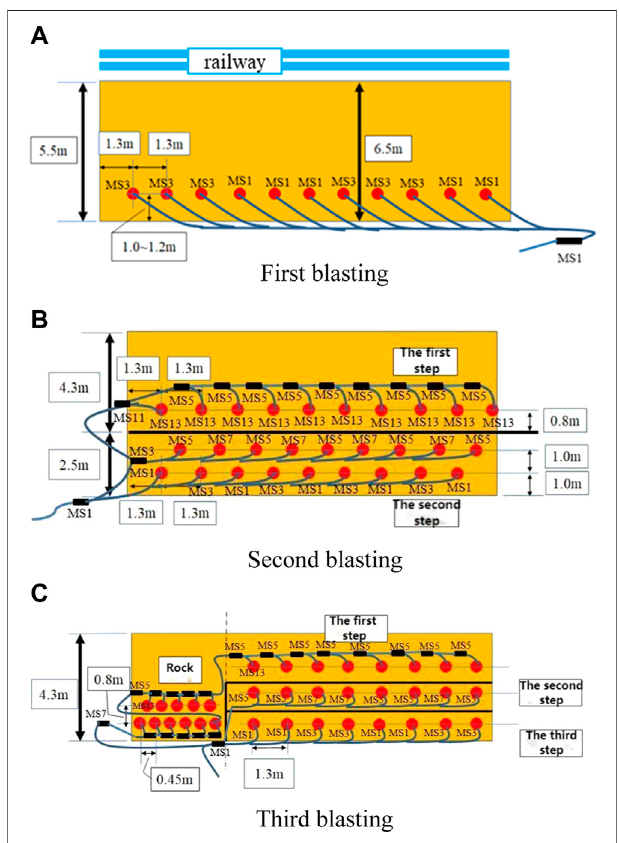
FIGURE 9 | Layout and igniting network of three blasting